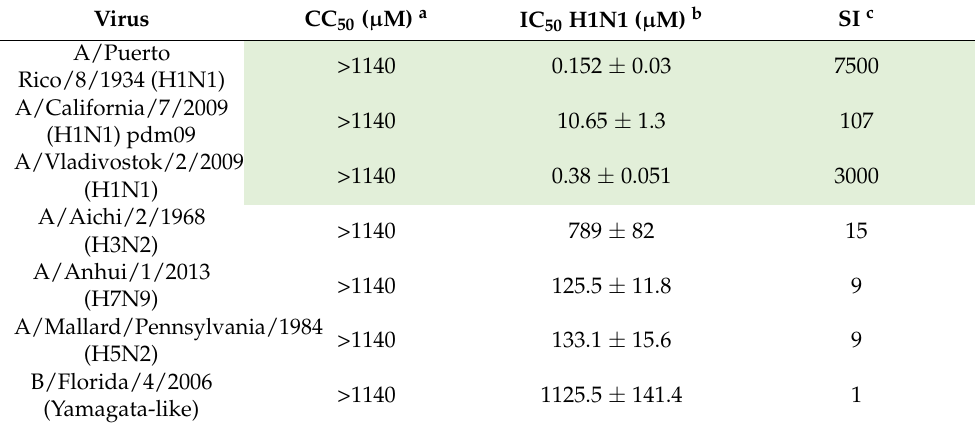
Table 2. The spectrum of inhibiting the activity of ginsamide against influenza viruses is based on the results of cytoprotection assay.